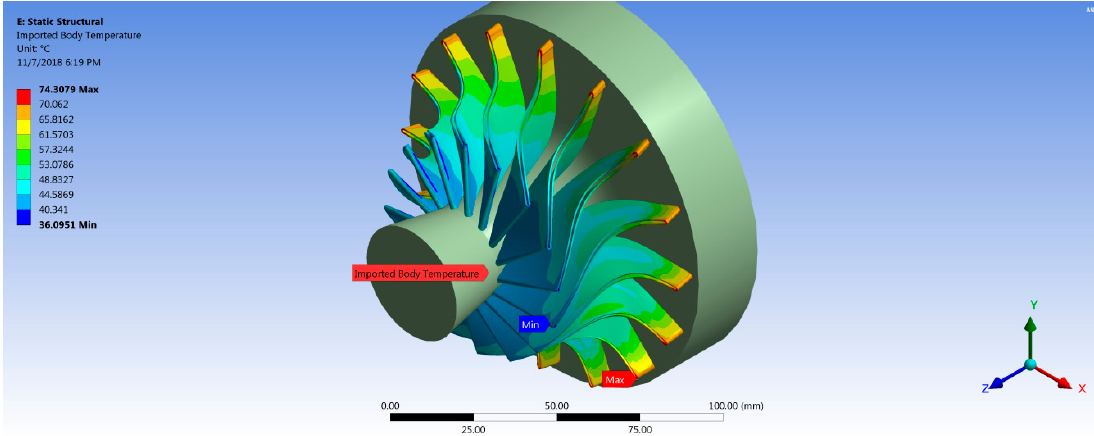
Figure 12. Imported temperature distribution for the rotor blades.